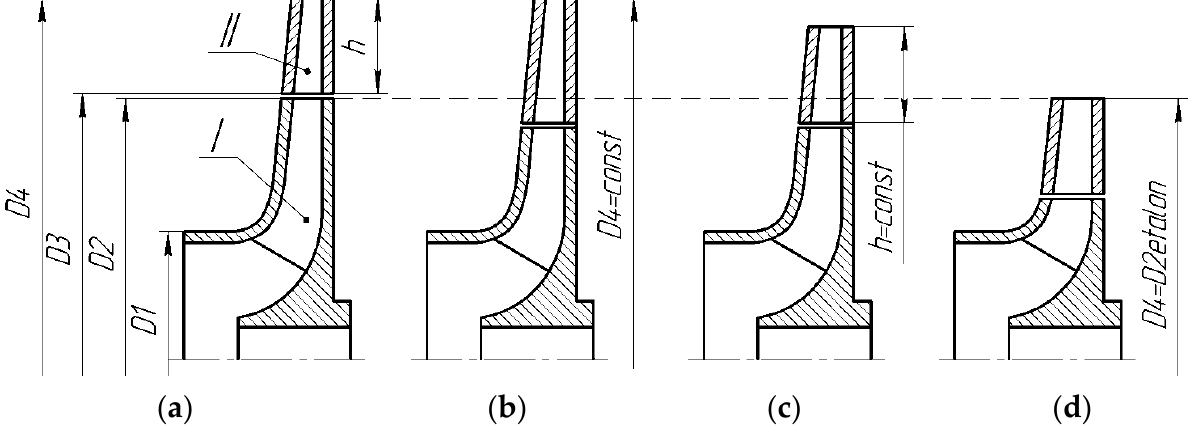
Figure 2. Counter-rotating stages: ( a ) Reference stage; ( b ) The elongated counter-rotating stage ( D 4 = c о nstant); ( c ) The replaced counter-rotating stage ( h = c о nstant); ( d ) The diameter D 4 of the counter-rotating stage equals to the diameter D 2 of the impeller for the reference stage.